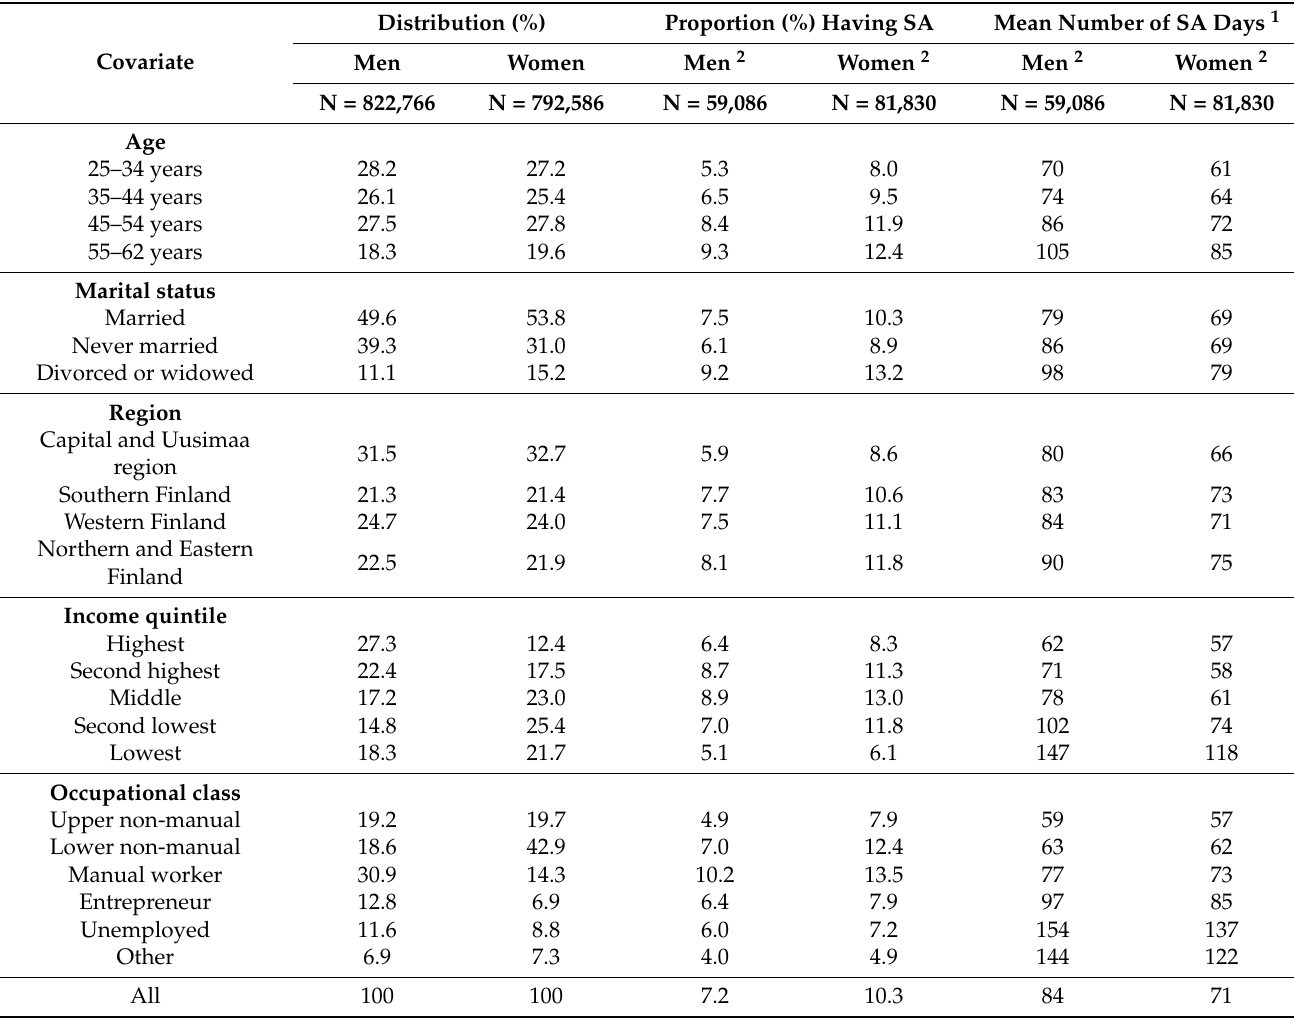
Table 1. Distributions of the study population in the end of 2012, proportion (%) of persons having all-cause sickness absence (SA) in 2013 and mean number of sickness absence days among persons with sickness absence